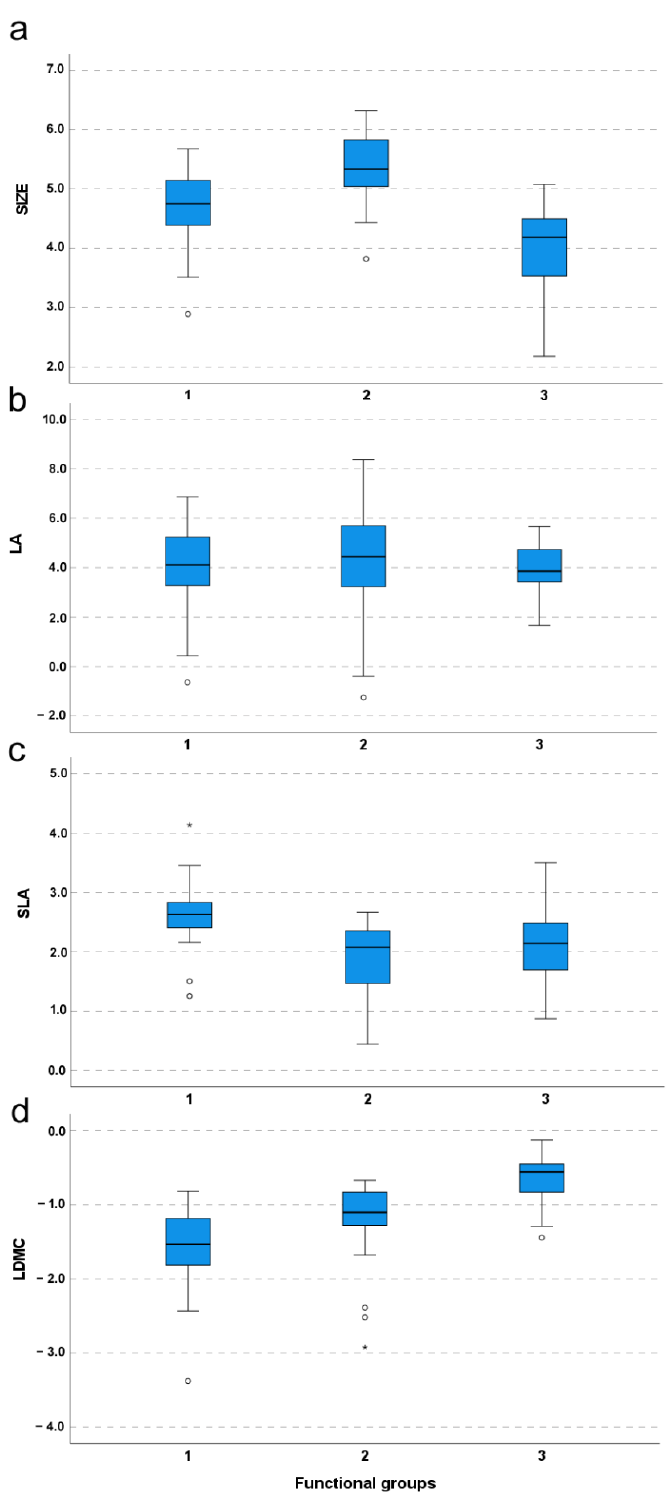
Figure 2. Variation patterns of the four functional traits (( a ) = SIZE; ( b ) = LA; ( c ) = SLA; ( d ) = LDMC) across the functional groups (FGs) produced by the cluster analysis as presented in Figure 1a. All values have been log-transformed. Abbreviations: SIZE = plant size; LA = leaf area; SLA = specific leaf area; LDMC = leaf dry matter content.